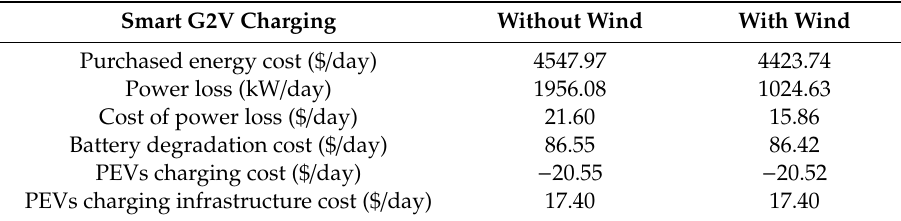
Table 4. Power Loss and Costs of Smart G2V Charging